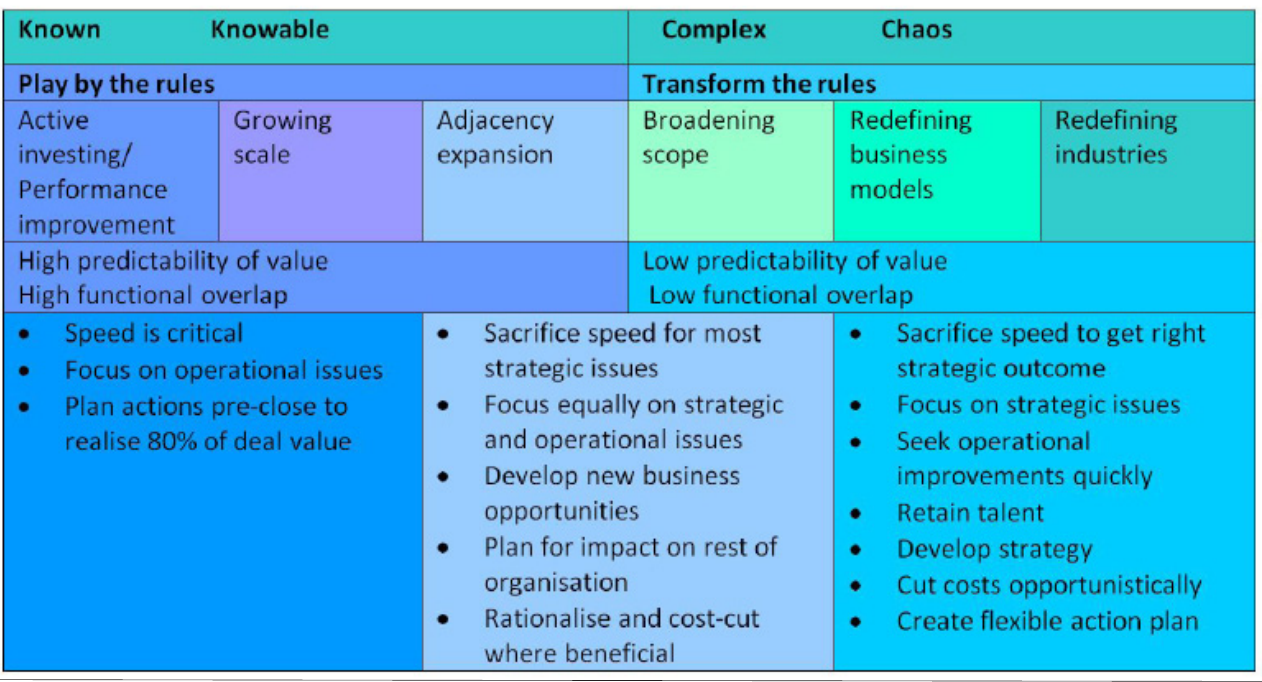
FIGURE 5: Strategic rationales and the Cynefin